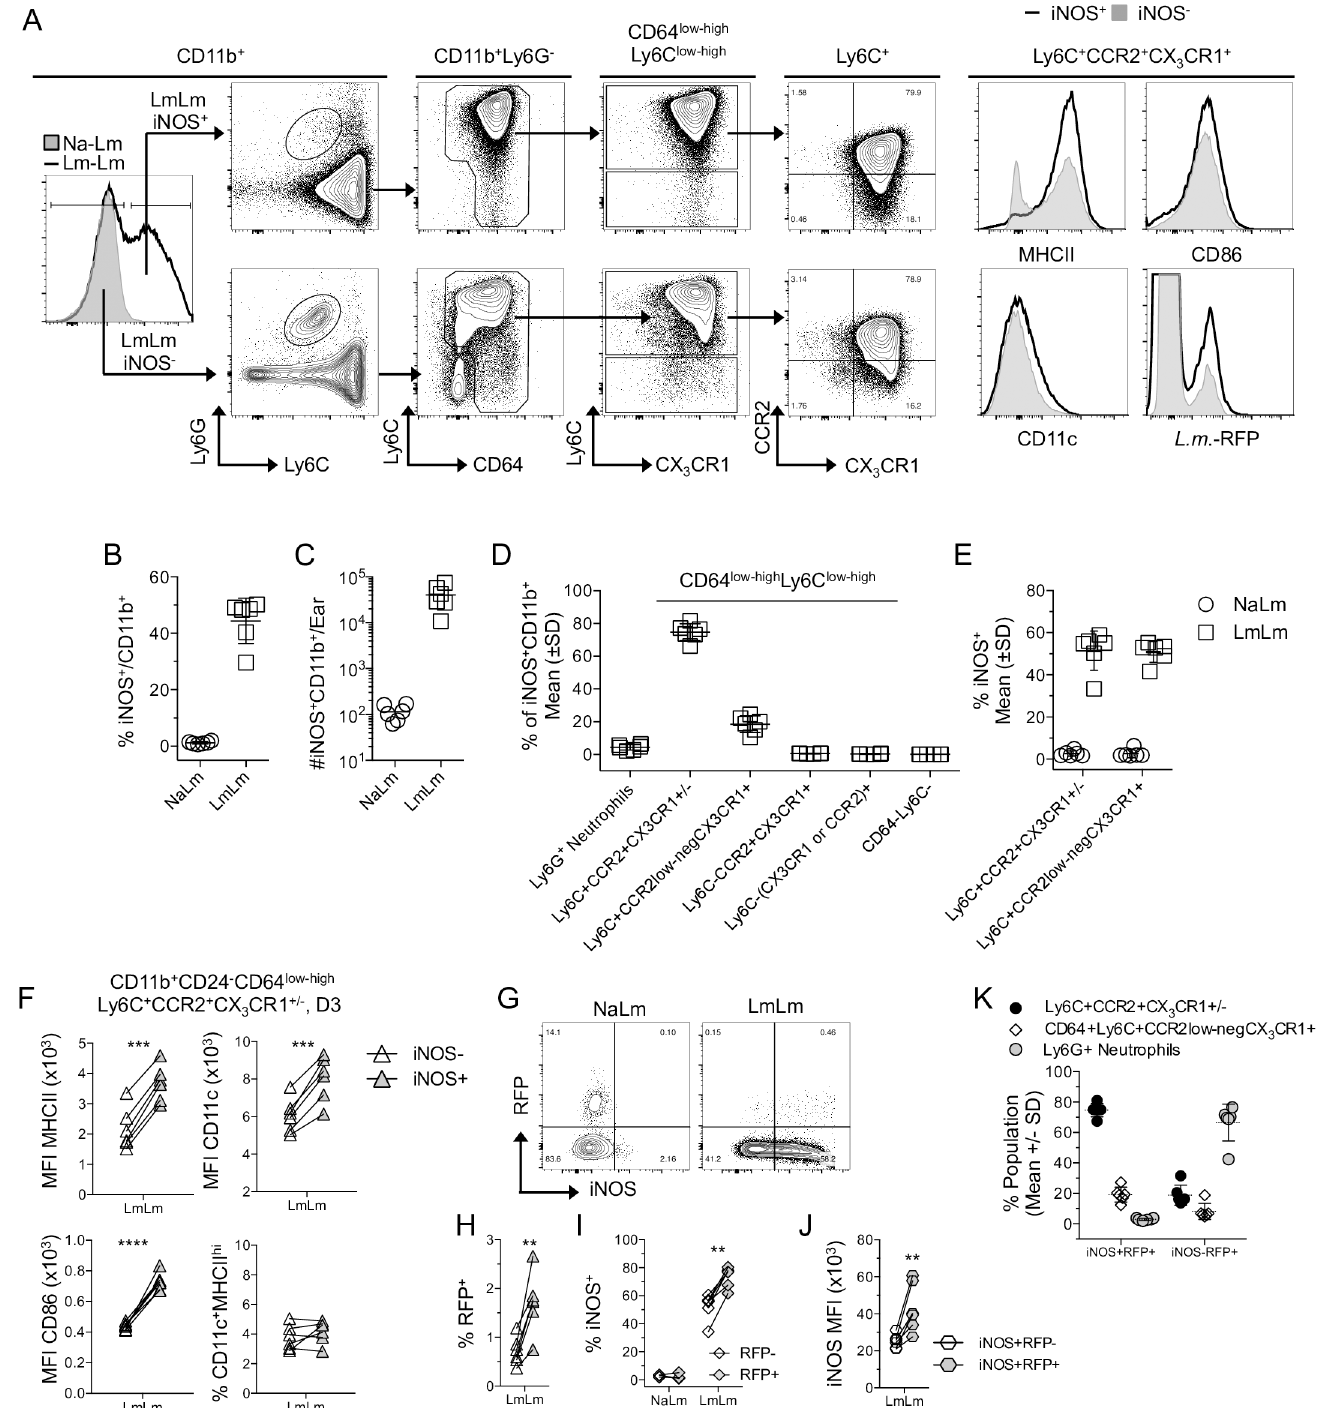
Fig 5. Immature inflammatory monocytes are the predominant iNOS + cell type at sites of L . major challenge. Mice as describedin Fig 4 were analyzedfor iNOS expressionon day 3 post-ch. with L . major -RFP. (A) Representative histogram and plots of iNOS + or iNOS - cells. (B) % or (C) absolutenumber of CD11b + cells that are iNOS + on day 3 post-ch. (D) Frequency of the indicatedpopulations within the total iNOS + CD11b + population. (E) Percentageof the indicatedpopulationson the x-axis that are iNOS + . (F) MHCII, CD11c, CD86 MFI of, and % of CD11c + MHCII hi cells within iNOS + or iNOS - monocytesobtainedfrom the same site of infection. (G) Representative RFP and NOS2 stainingof the populationdescribedin (F). (H) Percentage of iNOS + or iNOS - monocytes gated as in (F) that are RFP + . (I) Percentageof RFP + or RFP - monocytes gated as in (F) that are iNOS + . (J)